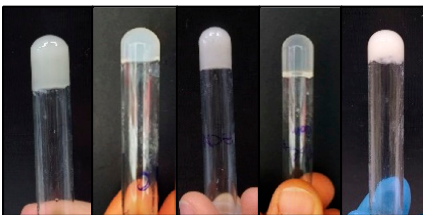
Figure 1. Photographs of the organogels obtained using a 2% w / w concentration of gelator A in the following solvents listed as function of their polarity (from left to right): toluene, ethyl acetate, acetonitrile, ethanol, methanol.